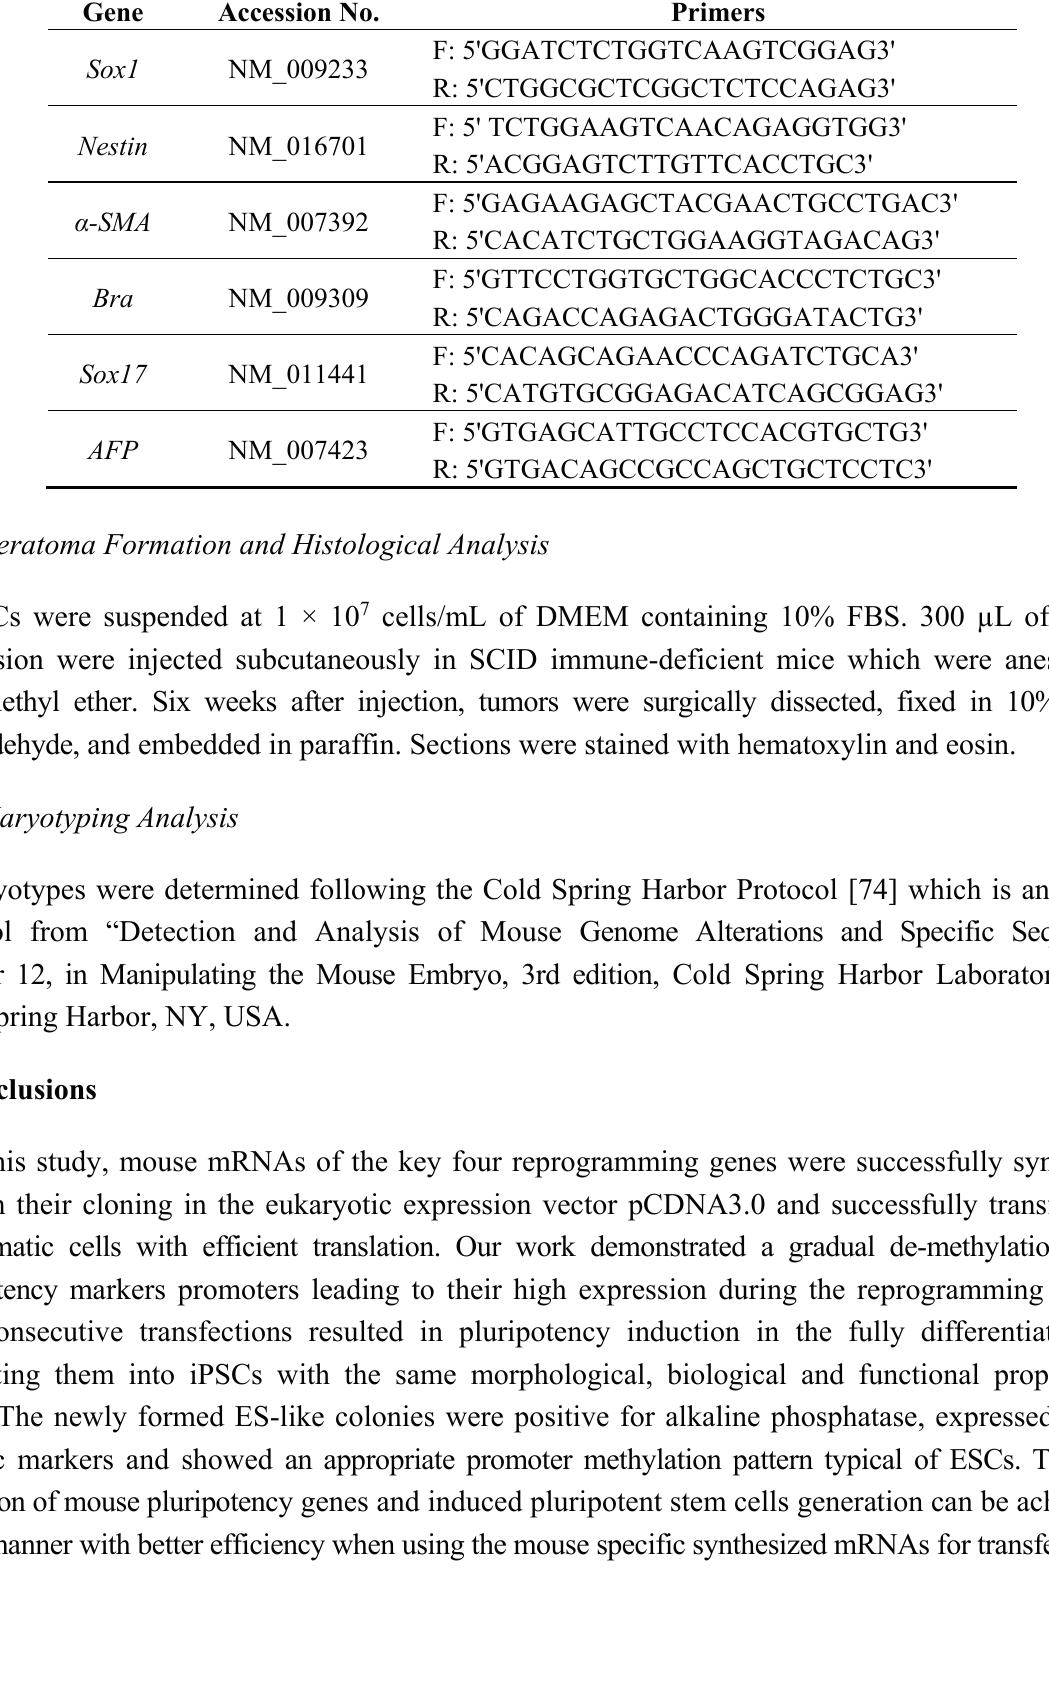
Table 4. Primers used for detection of the three germ layers in the formed Embryoid bodies. Gene Accession